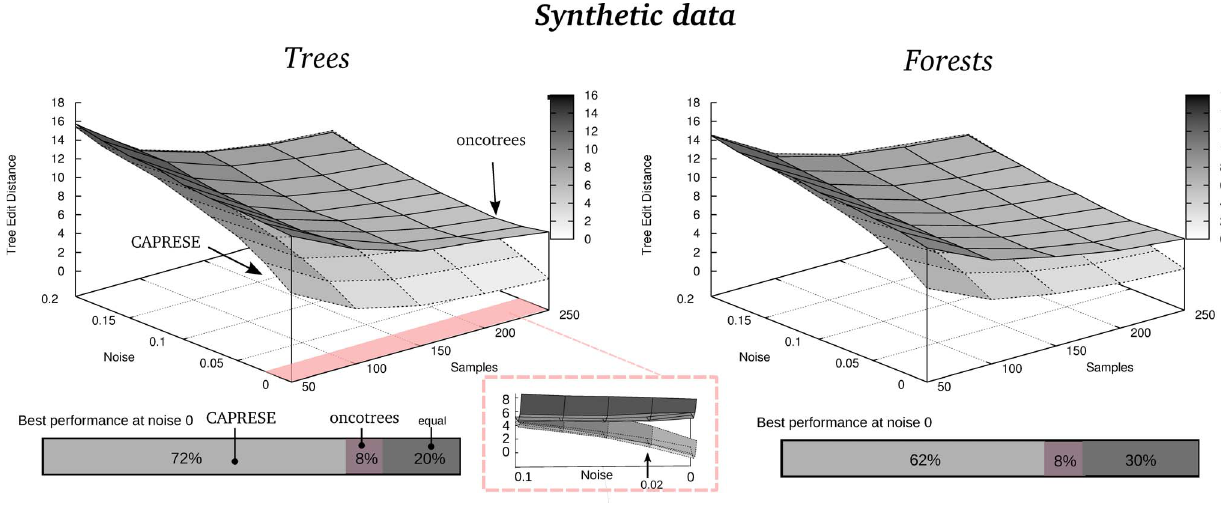
Figure 6. Reconstruction with noisy synthetic data and l ~ 1 = 2 . Performance of CAPRESE and oncotrees as a function of the number of samples and noise n . According to Figure 2 the shrinkage-like coefficient is set to l ~ 1 = 2 . The magnified image shows the convergence to Desper’s performance for n & 0 : 1 . The barplot represents the percentage of times the best performance is achieved at n ~ 0 .